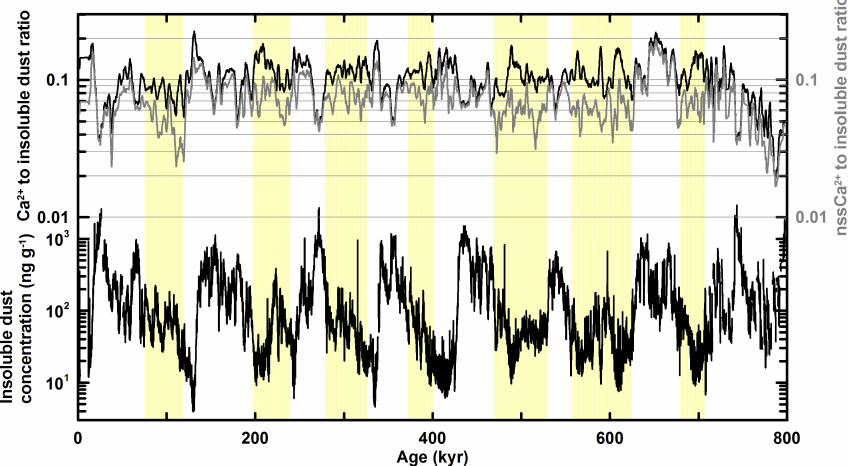
Fig. 3. Insoluble dust concentrations in ngg − 1 with ratio of Ca 2 + and dust (in black), and nssCa 2 + and dust (in grey) concentrations, using 100yr median values on a logarithmic scale. Ratios have been smoothed by a 2500 year running